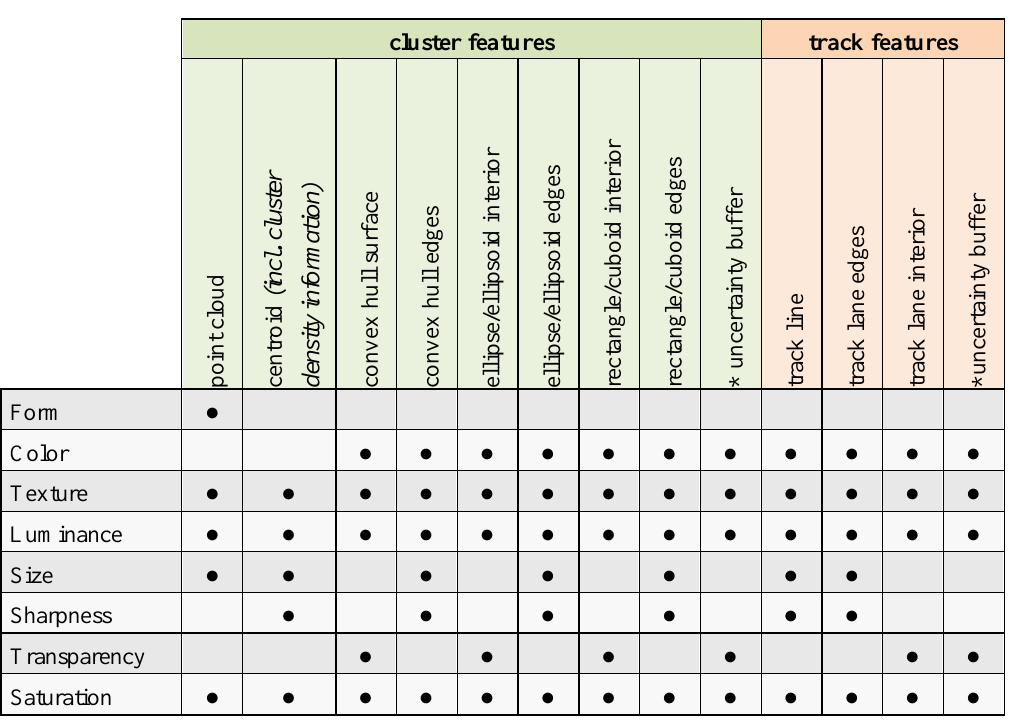
Table 3. Graphic variables of cluster and track